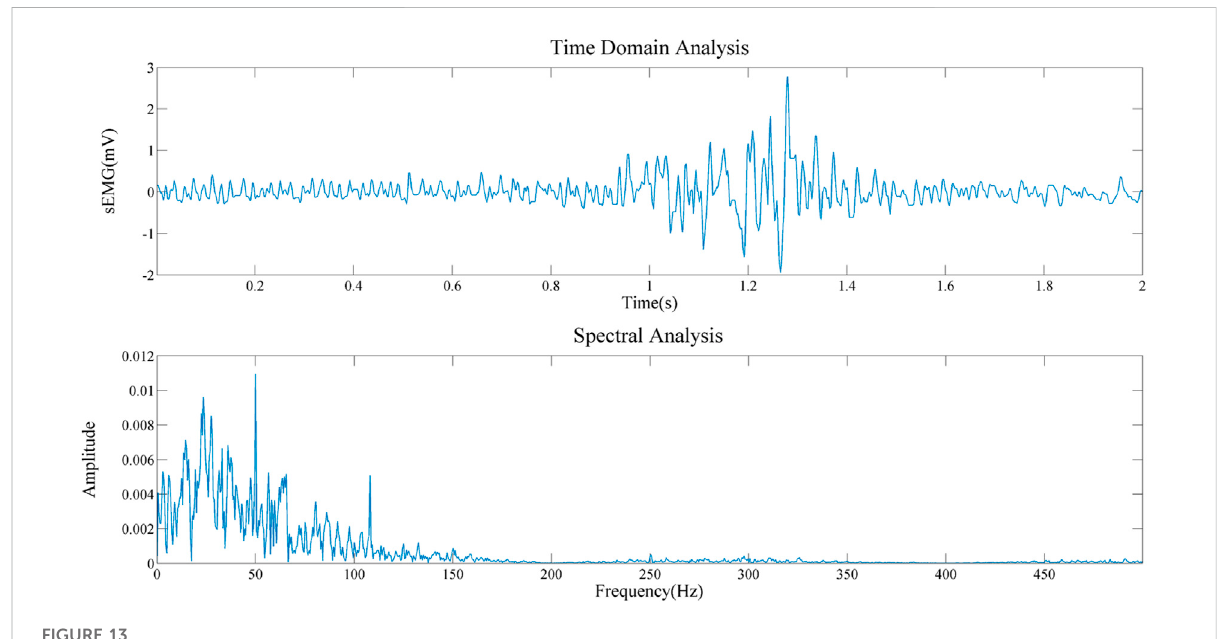
FIGURE 13 Frequency domain analysis in the static state.